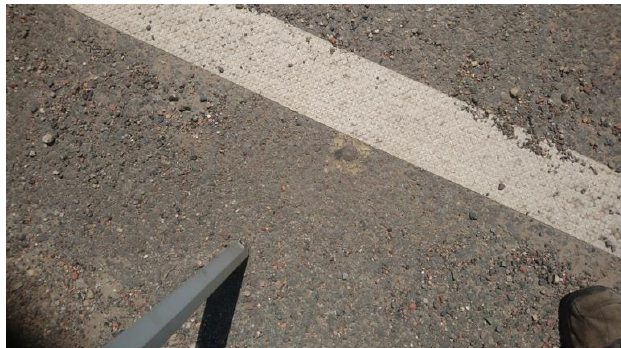
Figure 11. Location of the measurement line with the marked area revealing linear discontinuous deformations.